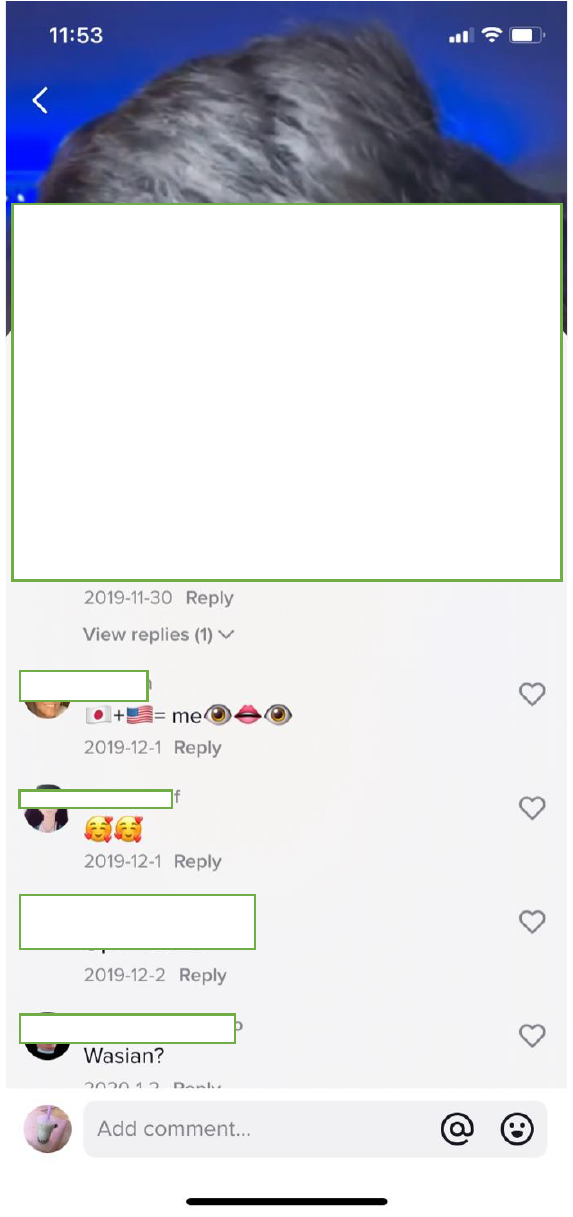
Figure 4. Emoji Comments.